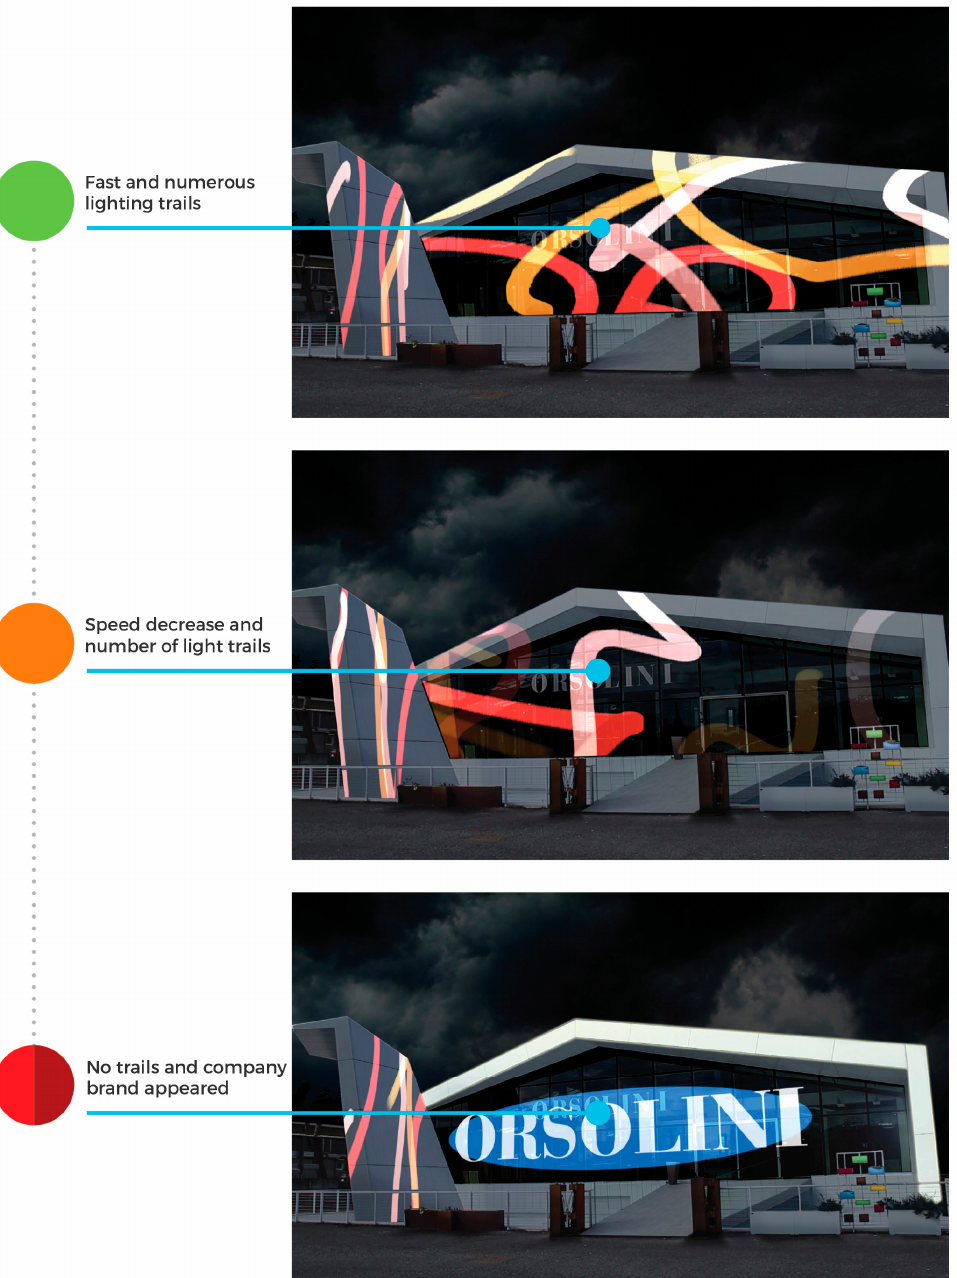
Figure 12. Dynamic urban projection mapping application (image by Rosario Di